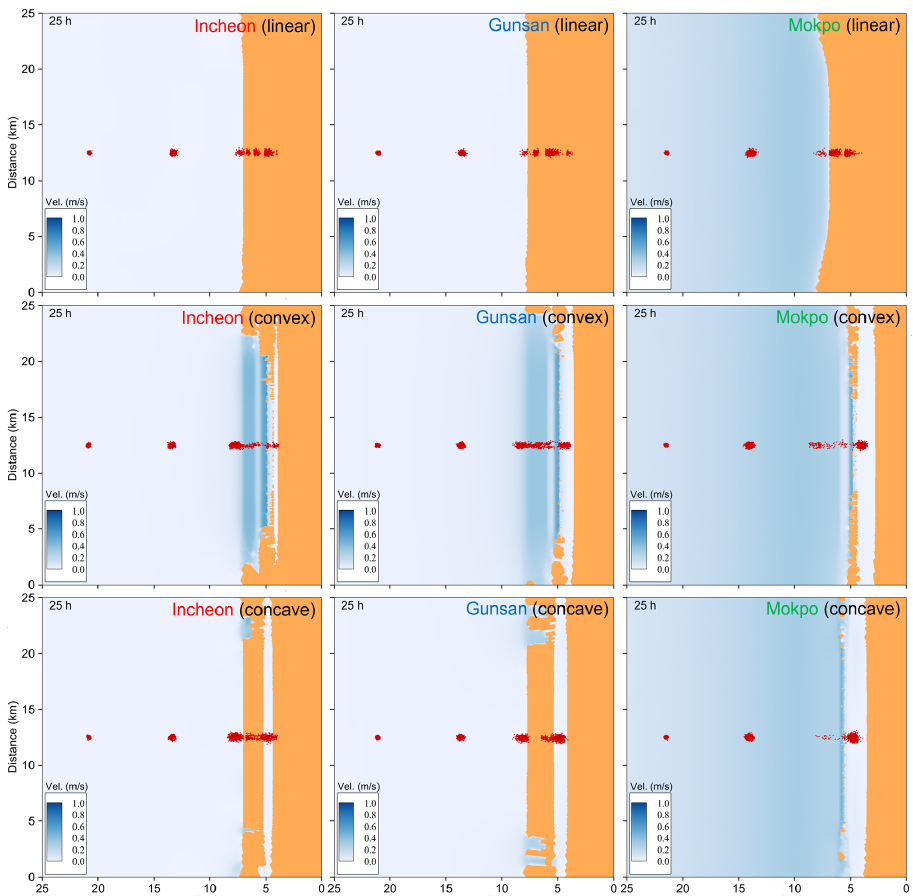
Figure 9. Particle behavior in the idealized wet–dry zone with respect to the bottom